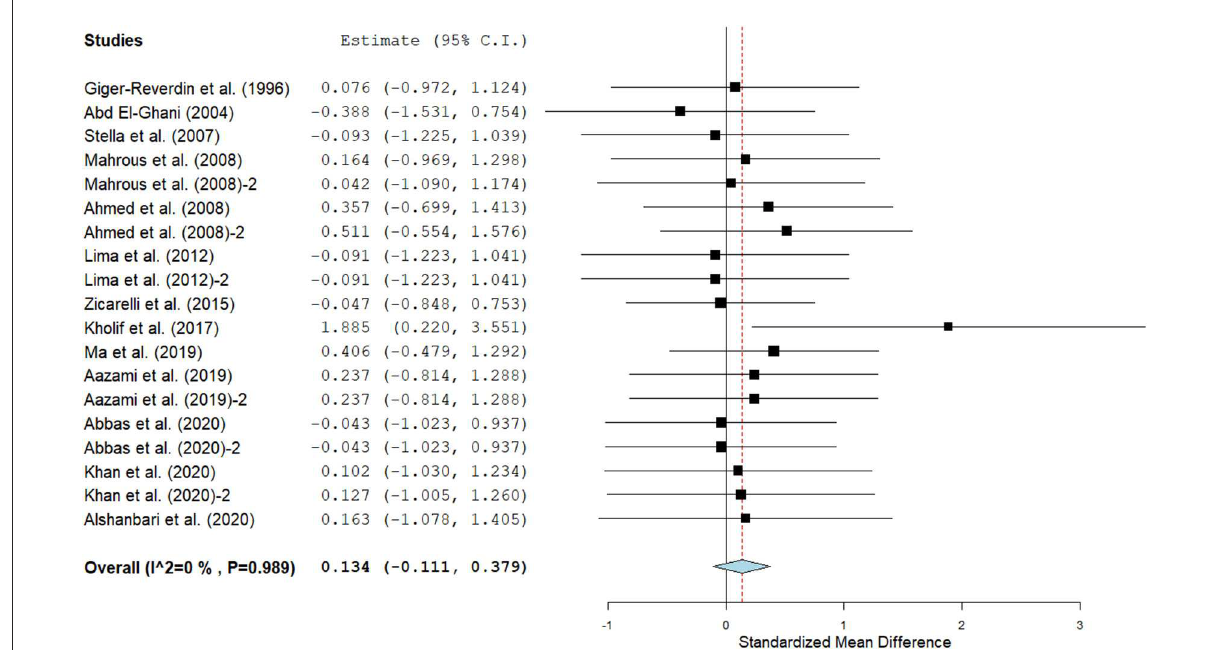
FIGURE6 Forest plot of the effect of SC on milk lactose in lactating goats. The error bars connote the SMD of each trial, while the upper and lower 95% CIs for the effect size are the line that joined the individual square box. The thick vertical line is the line of no effect (SMD = 0), which suggests no effect of SC supplementation on milk lactose. The sky-blue diamond at the base of the plot indicates the pooled SMD with its width representing the 95% confidence intervals for the effect size. The points to the right of the line of no effect suggest an increase in milk lactose. The points to the left of the line of no effect connote an increase in milk lactose. I 2 is the inconsistency index.